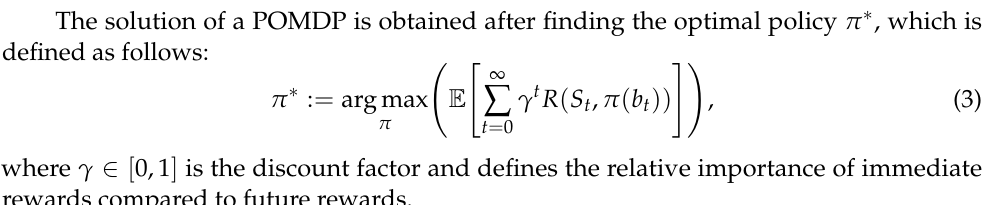
Figure 4. Belief tree and motion policy representation in partially observable MDPs (POMDPs). Each circle illustrates the system belief as the probability distribution over the system states (red dots). When an observation is made, the belief distribution is subsequently